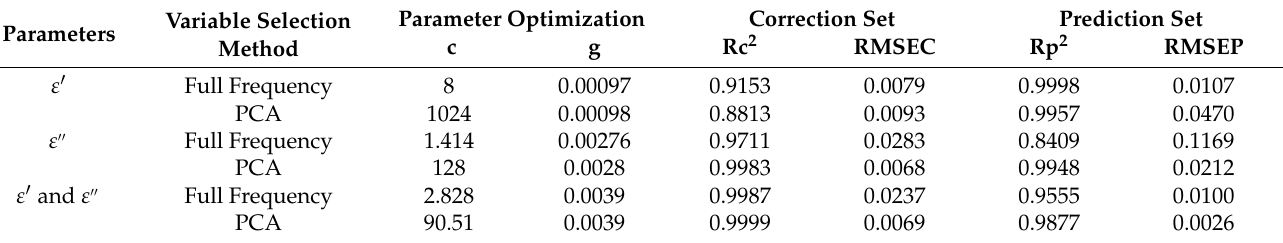
Table 3. Prediction Results and Parameter Optimization of Support Vector Machine